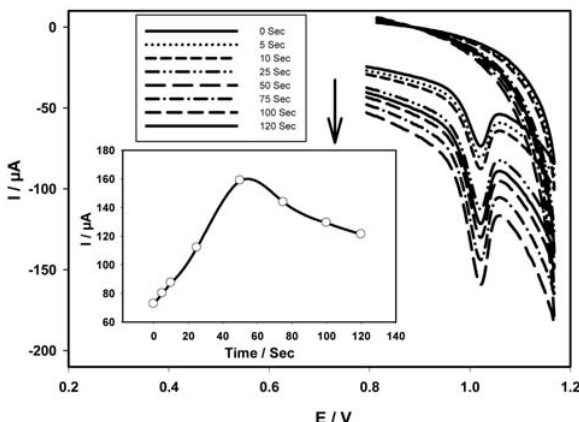
Figure 9: Anodic peak current of 1.0 × 10 –3 mol/L MET solution at PYCPE as a function of accumulation time in BR Buffer of pH 2.0. The inset: plot of the anodic peak current values versus accumula- tion